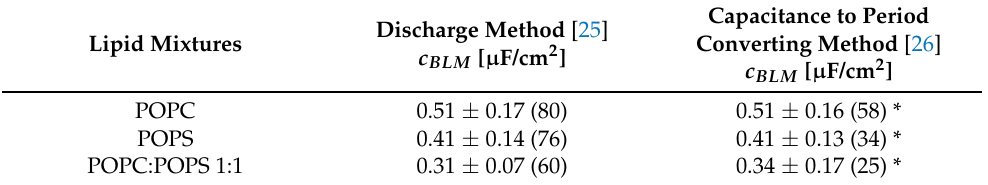
Table 1. Specific capacitance of planar lipid bilayers ( c BLM ) measured by discharge and capacitance to a period converting method. The values are given as mean ± standard deviation (number of measurements).